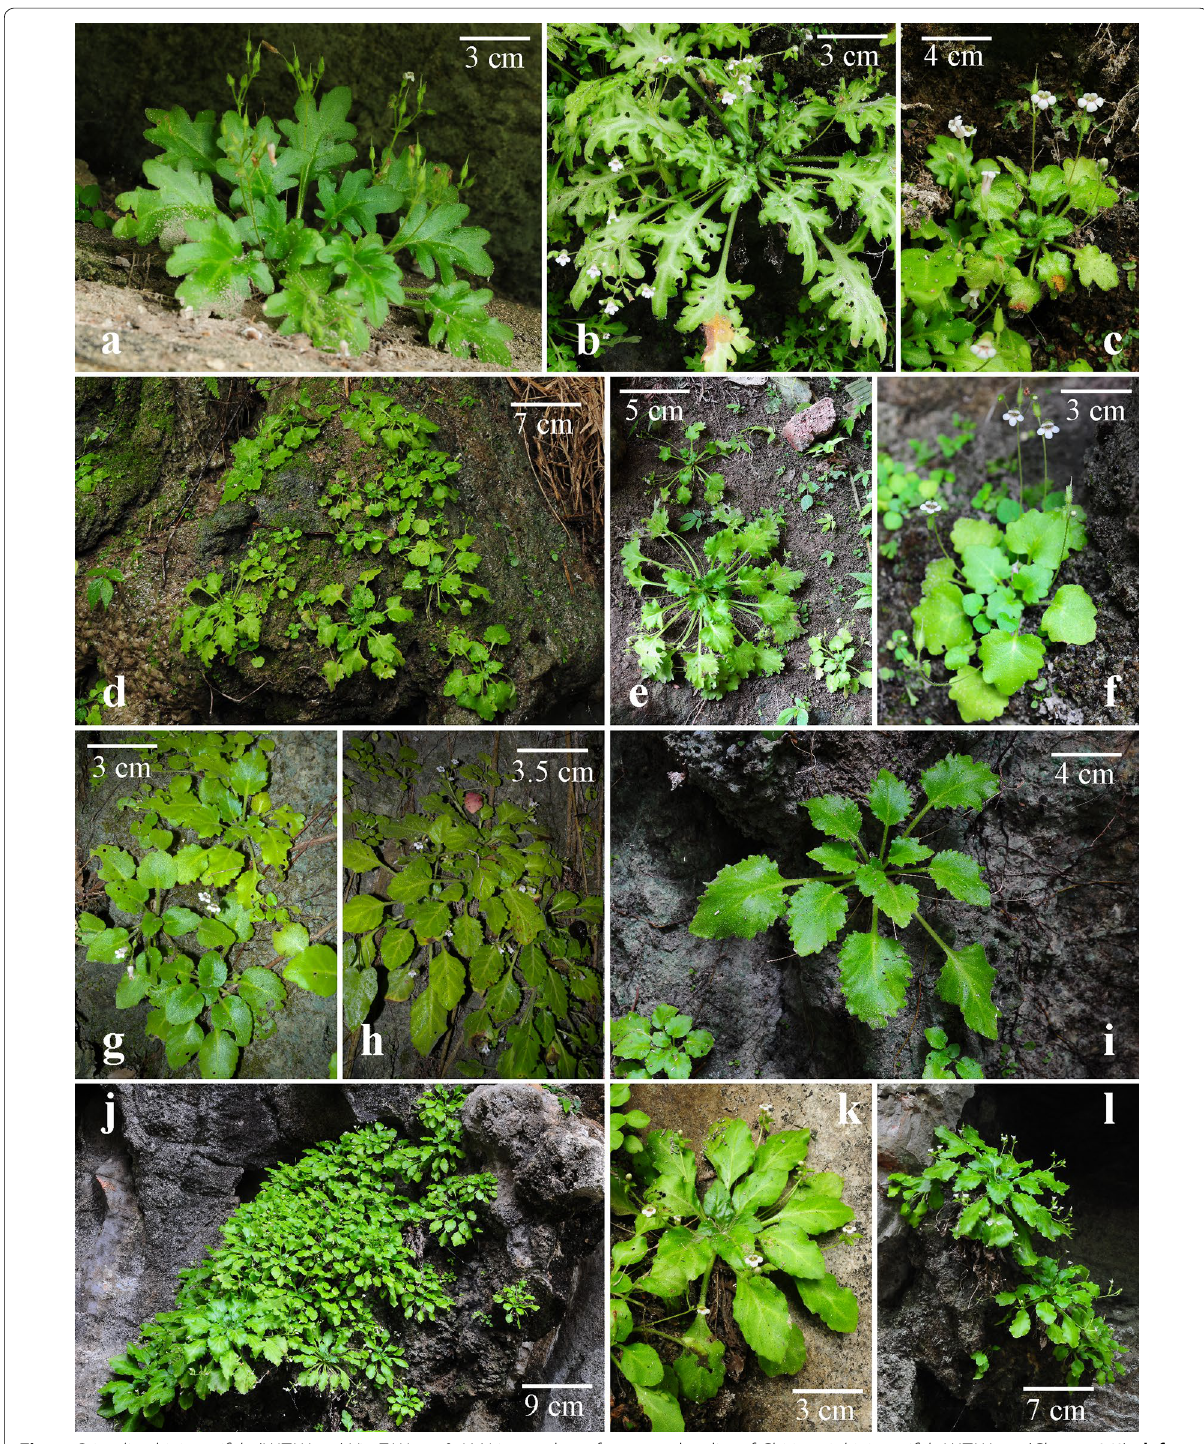
Fig. 7 Primulina bipinnatifida (W.T.Wang) Yin Z.Wang & J.M.Li. a – c plants from type locality of Chiritopsis bipinnatifida W.T.Wang ( Chung 1863 ); d – f plants from Linggui ( Chung 1865 ); g – i plants from Yangshuo ( Chung 1858 ); j – l plants from Lingchuan ( Chung 1805 & 3028